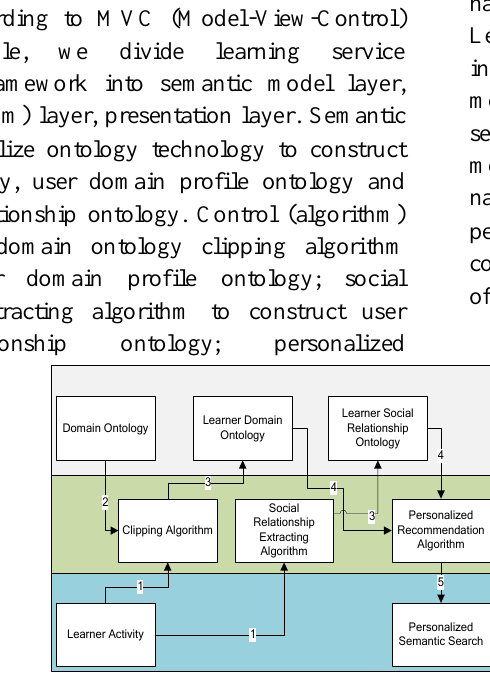
Fig 1. Learning Service Personalized